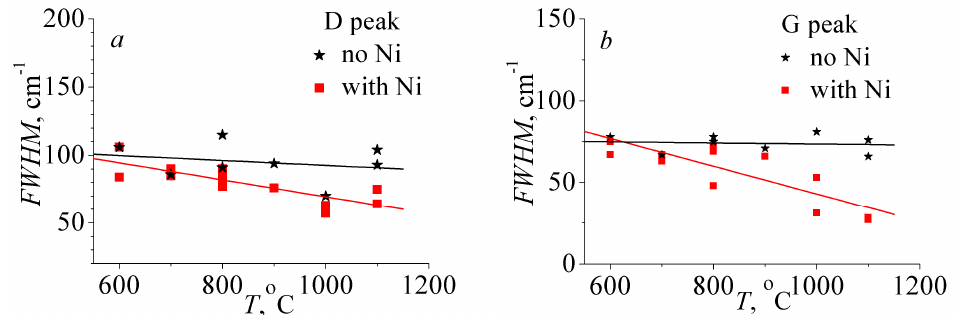
Figure 10. Peak width ( FWHM ) as a function of heat treatment temperature for nickel-containing and control samples: ( a ) for D peak, ( b ) for G